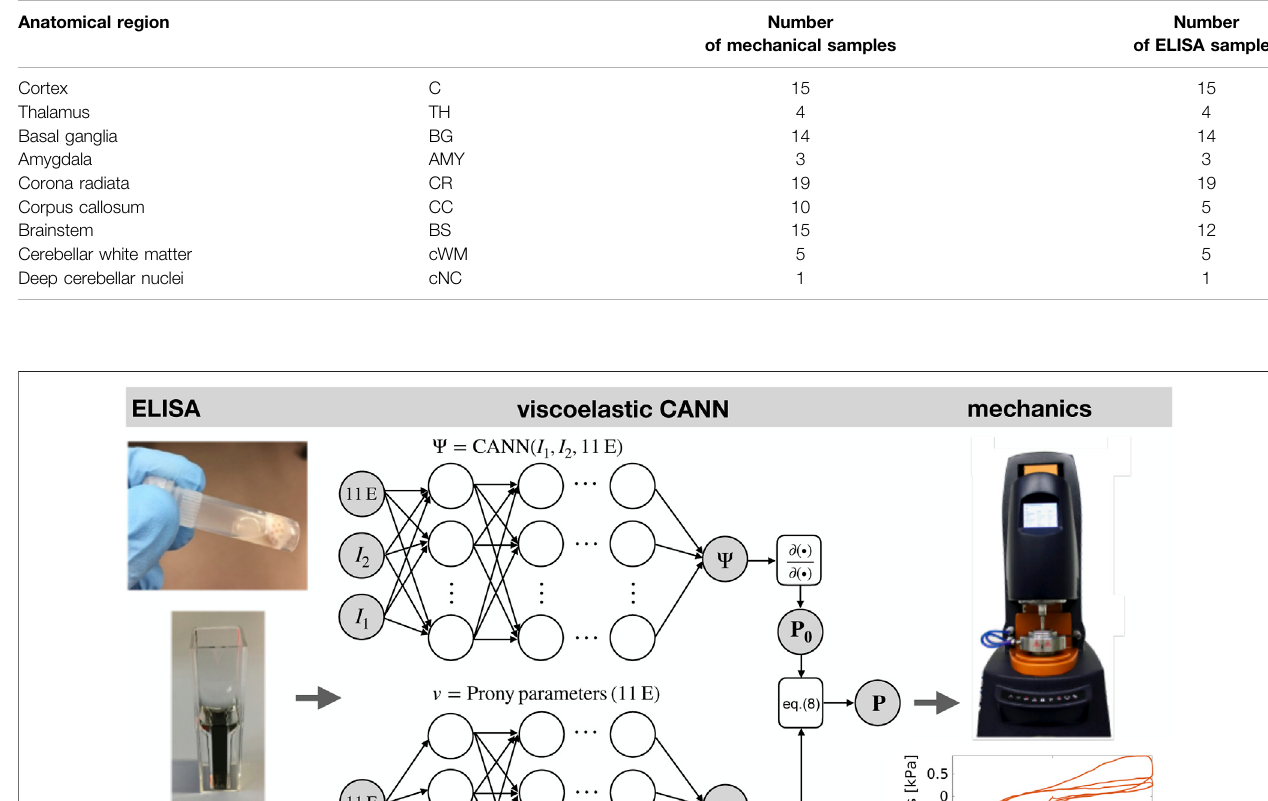
TABLE 2 | Samples for mechanical testing and ELISA. Anatomical region Number